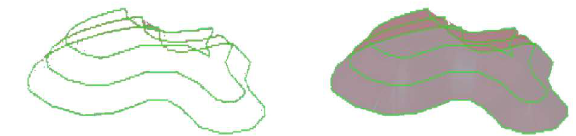
Figure 5: Converting contourlines into a 3D file for further volume calculations.